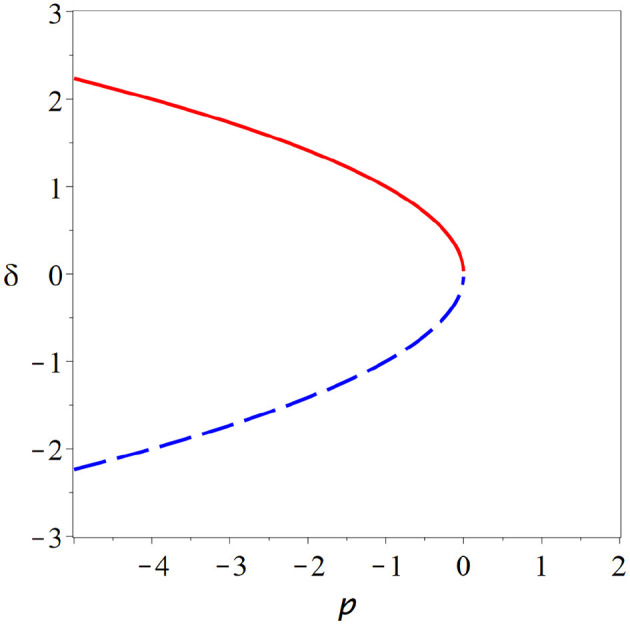
Fold bifurcation. As parameter p is changed two steady states (red solid, blue dashed) collide and annihilate (cf. Equation 26). At the bifurcation point, where the steady states meet the system is supersensitive to parameter change. But due to the instability of the bifurcation point and the lack of states beyond the bifurcation point, it seems implausible that the brain could remain in such a state.